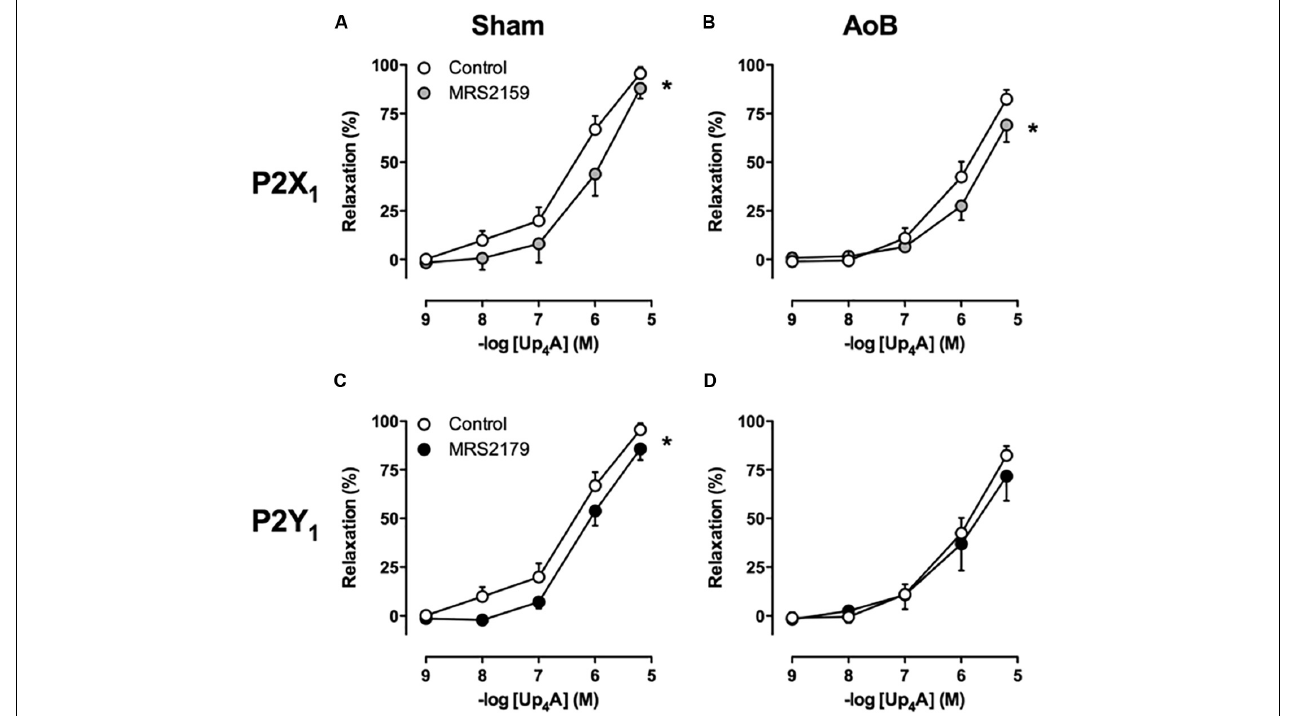
FIGURE 6 | P2X 1 receptor blockade with MRS2159 attenuated relaxation to Up 4 A to the same extent in coronary small arteries from Sham-operated swine ( A , n = 8) and from swine with AoB ( B , n = 6), whereas and P2Y 1 receptor blockade with MRS2179 attenuated relaxation to Up 4 A in coronary small arteries from Sham-operated swine ( C , n = 7) but not from swine with AoB ( D , n = 5). Control data are the same as in Figure 2 (‘Sham’ and ‘AoB’). ∗ P < 0.05 effect of MRS2159 or MRS2179 vs. corresponding